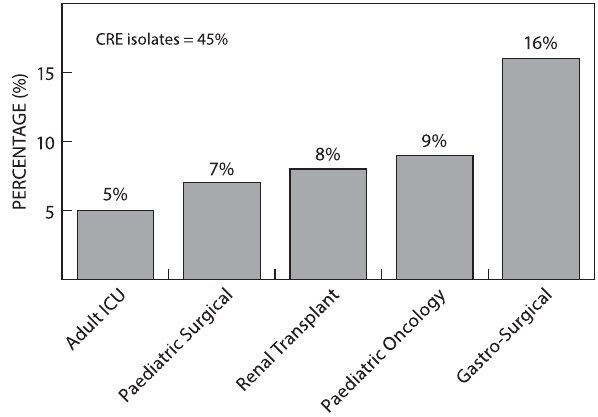
Figure 2: Top 5 areas with the highest CRE prevalence